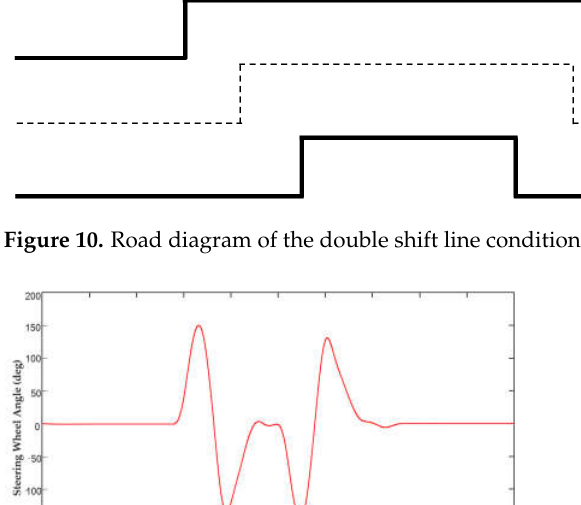
Figure 11. Steering wheel angle at the double shift line condition.